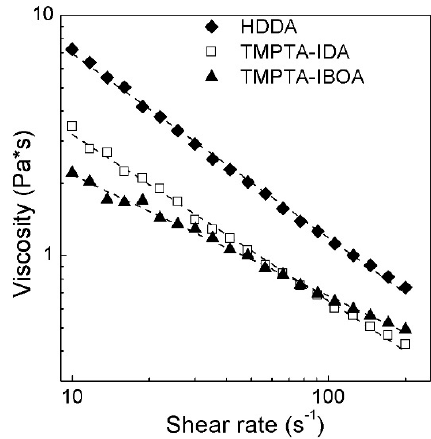
Figure 5. Viscosity of different acrylic monomers and their mixtures as a function of shear rate with 28 vol.% of 8YSZ at 20 °C.